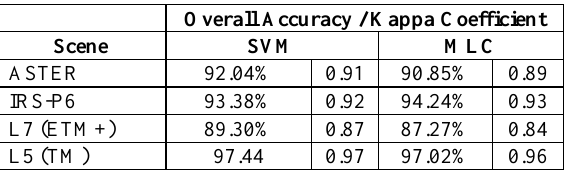
Table 6. Accuracy assessments results of the LU